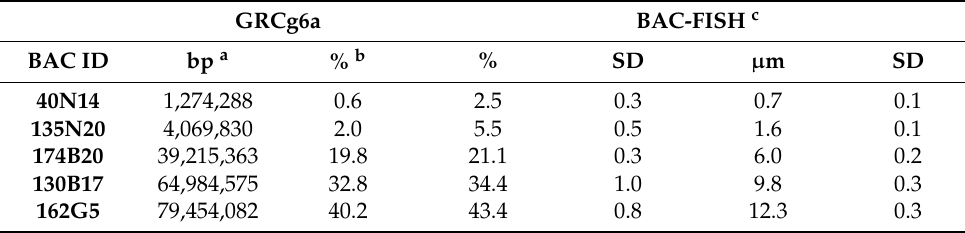
Figure 3. Localization of BAC clones on SC1 using FISH. ( A – D ): the SCs are labeled in green and the signal of the fluorescent in situ hybridization (FISH) probes in red. Each image shows the location of one or two BACs on SC1. The BAC IDs are shown in each image at the top left corner. The end of the short arm (p) can be identified by the position of the FISH signals which are asymmetric respect to the SC termini. Bar: 10 μm. Table 2. Positions of the BAC clones along GGA1 (GRCg6a) and the SC1